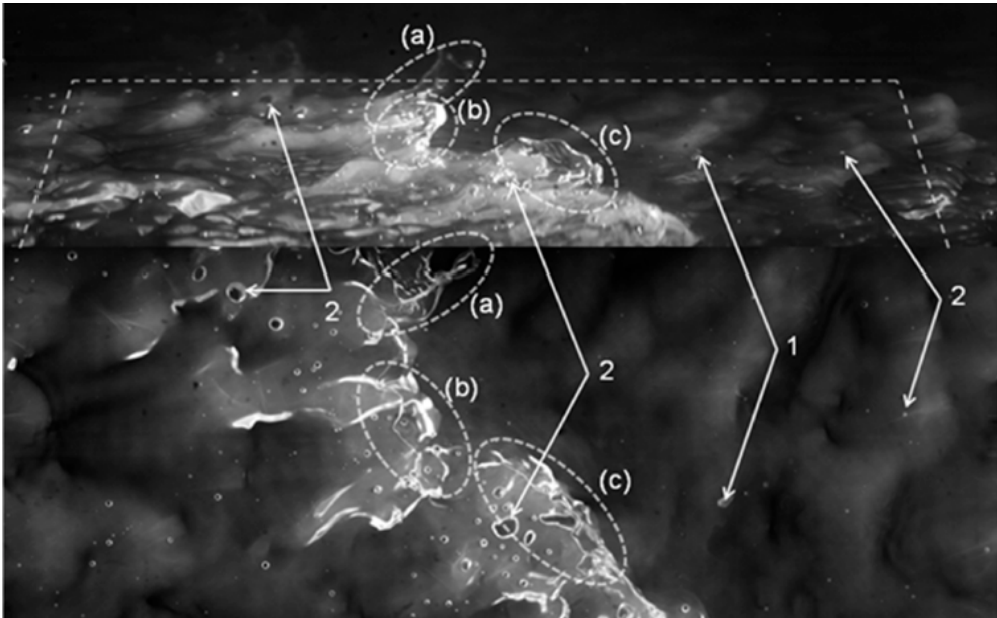
Figure 14. An example of simultaneous visualization of entrainment events in the x - z plane ( top image ) and in the x - y plane by the BBLIF-technique ( bottom image ). Entrained droplet (1) and entrapped bubbles (2) are shown for both images. Fast ripples (a–c) are shown in both images; ripple (a) is being shattered into droplets, and ripples (b,c) are in the process of growth and overturning [59]. The imaged area is 52 mm by 20 mm. The dashed trapezium shows the borders of the image viewed in the x - y plane.